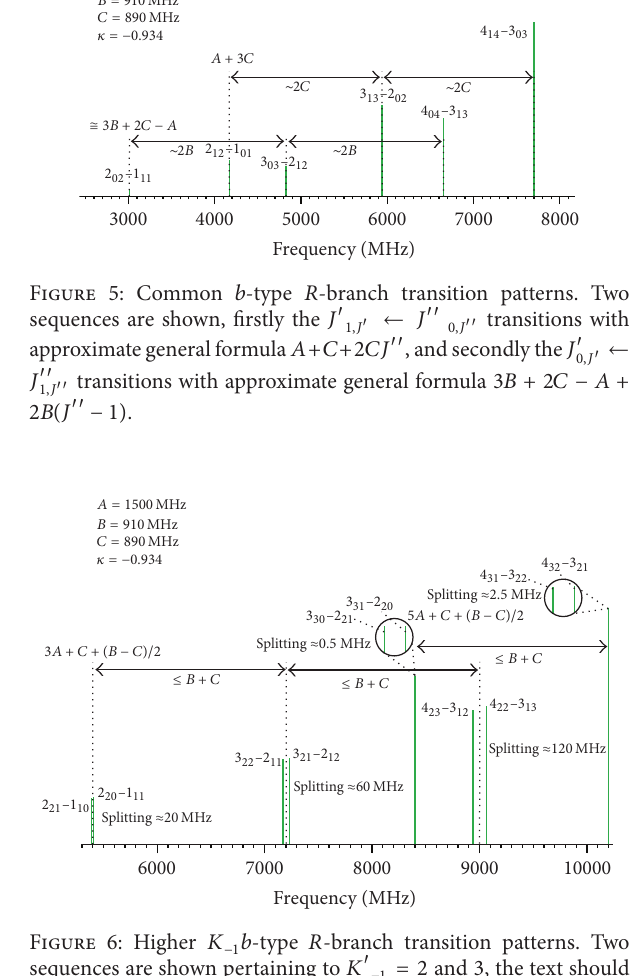
F 6: Higher -type sequences are shown pertaining to be consulted for further description. ese doublets are oen useful in making quantum number